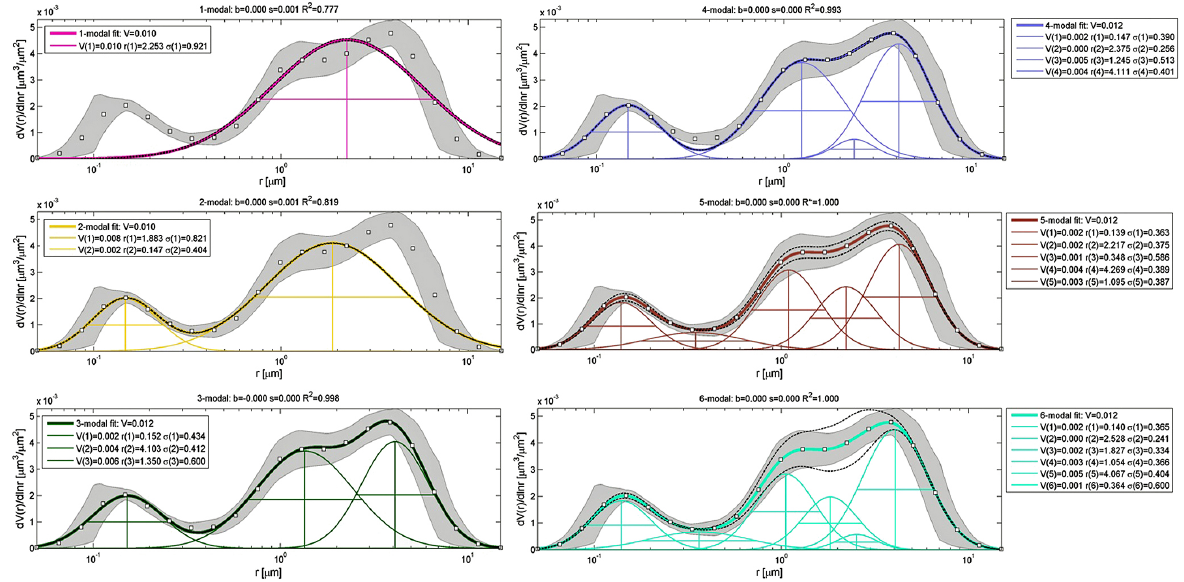
Fig. 4. Gaussian mixture model (GMM) one- to six-modal fits of the interpolated AVSD for dominant marine (sea salt) aerosol at Lanai, Hawaii, on 21 January 2002. The grey shaded region is the error on the AERONET data, and the black dotted lines (most visible in the five- and six-modal plots) are the 95% confidence level curves on the